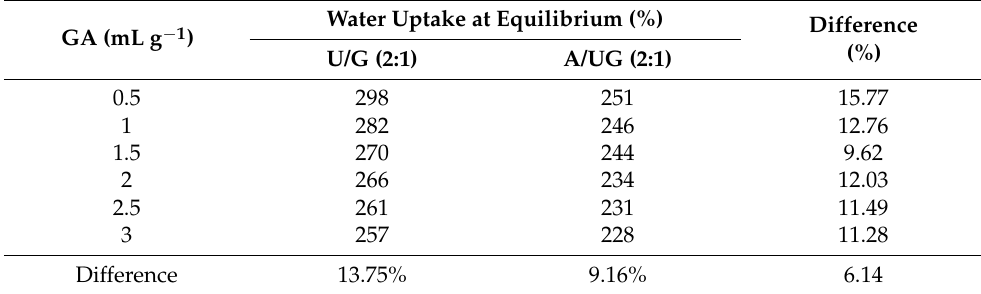
Table 1. Equilibrium water absorption for several films with differing GA